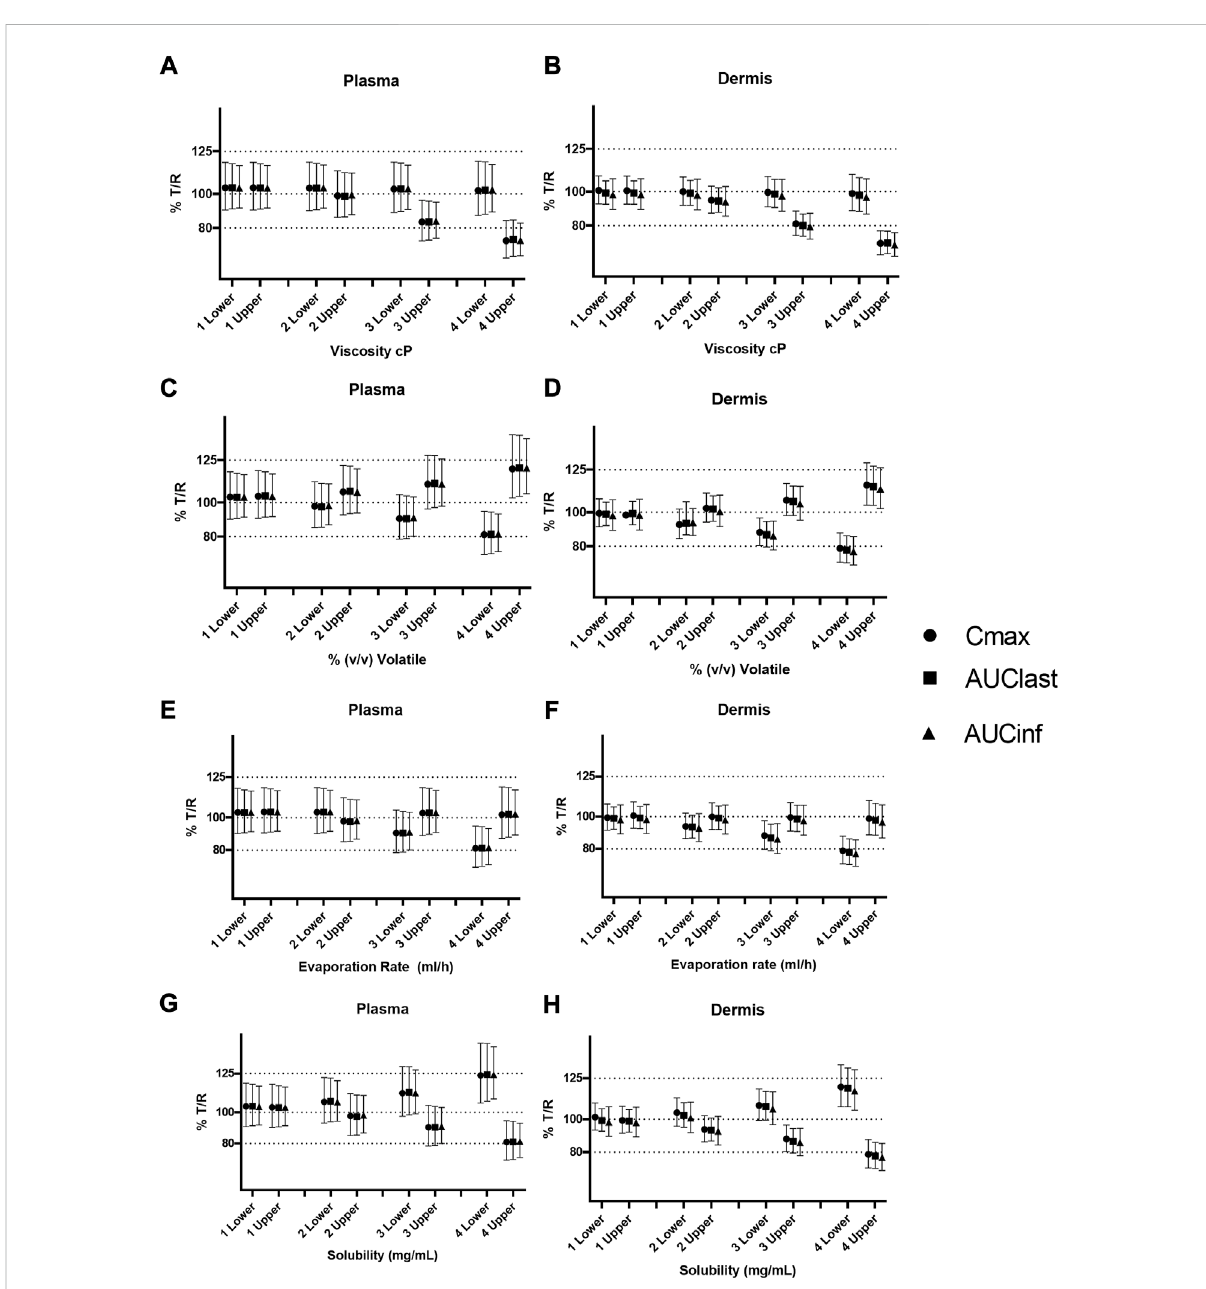
FIGURE 9 Safespaceanalysisforformulationparametersatdifferentdoses;viscosity (A,B) ,%v/vvolatilefraction (C,D) ,evaporationrate (E,F) ,andsolubility (G,H) . One lower/upper represents the low dose (1 spray per 10 cm 2 ); 2 lower/upper represents the middle dose (1spray per 2 cm 2 ), and 3 lower/ upper represents the default dose (1 spray per 1 cm 2 ), respectively, 4 upper/lower represents the dose equivalent to the IVPT study (3.5 sprays per 1 cm 2